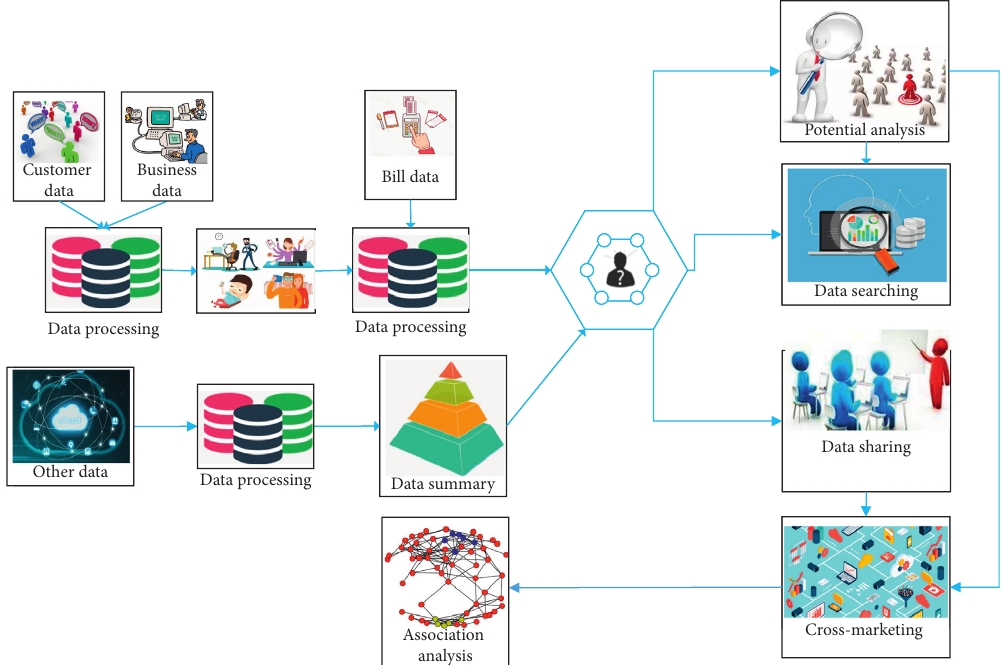
Figure 1: The structure of potential characteristics model.